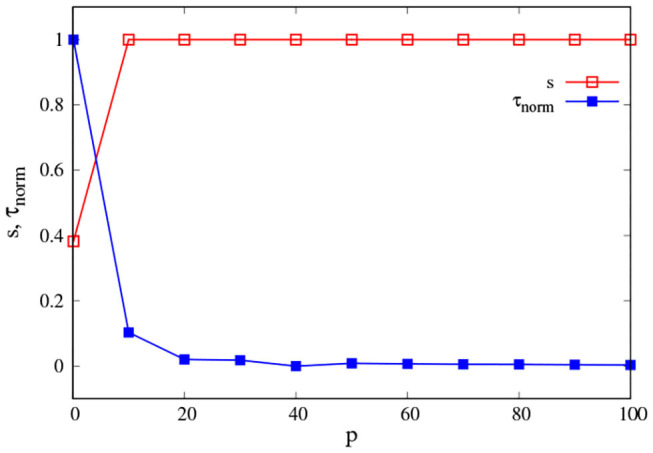
Environmental interaction. Average success rate s (red squares) and average first-arrival time τ (blue squares) as a function of p. The curves are the result of averaging 500 different experiments with t = 2, 500 each one, with ξ = 0.5 and κ = 0.05. For a better reading of the graph we considered τnorm = (τ − τmin)/(τmax − τmin).